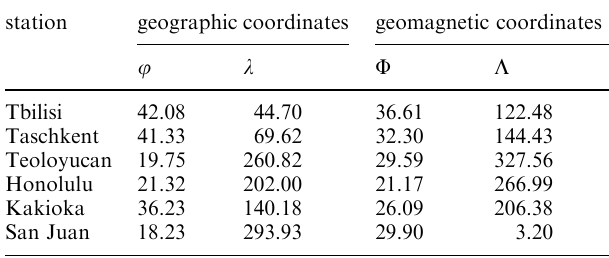
Table 1. Low-latitude observatories station geographic coordinates